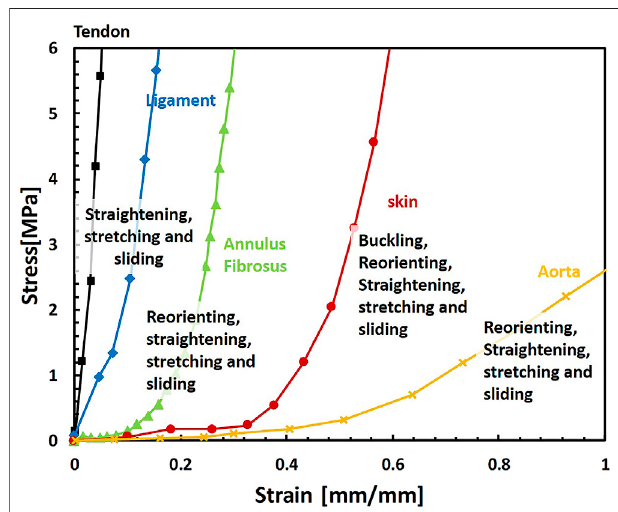
FIGURE1| Representativemechanicalbehaviorsofdifferentsoft fi brous tissues under uniaxial tension and related mechanisms of their deformation behavior: tendon (De Santis et al., 2004), ligament (De Santis et al., 2004), annulus fi brosus,(stretched inthe fi berdirection)(Shanetal.,2015),skin (Joodaki and Panzer, 2018) and aorta (Zhalmuratova et al., 2019). The Behaviors presented here are representative; different protocols, origins, and tissue types result in large variations of